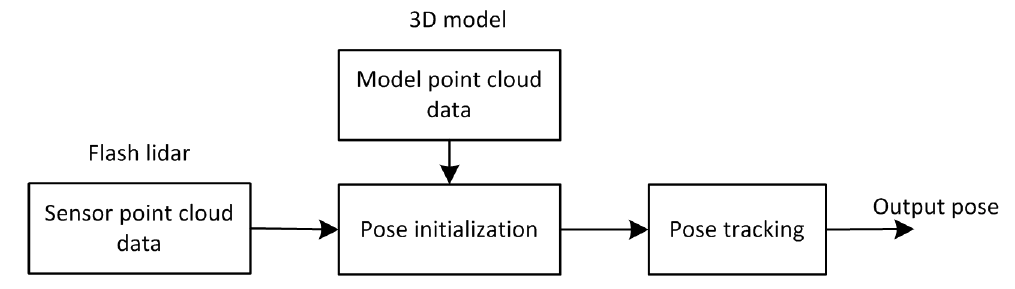
Figure 1. The diagram of the proposed method.